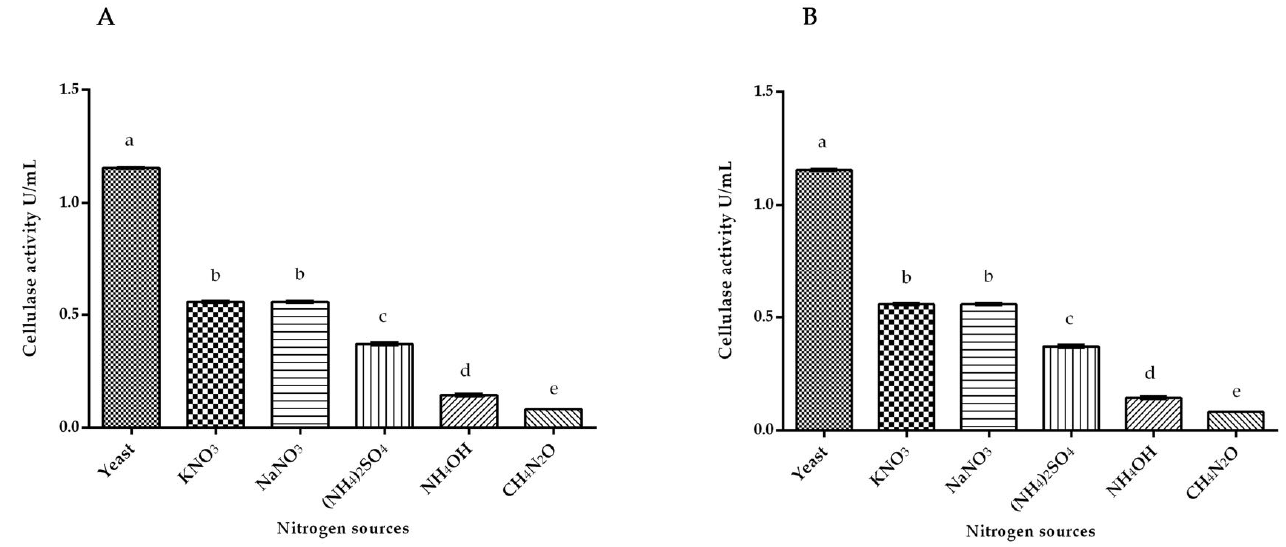
Figure 1. ( A ) Cellulase activity of white rot fungus P . ostreatus under submerged fermentation on different nitrogen inducers. Bars with different letters (a–e) are significantly different at p < 0.05. ( B ) Cellulase activity of white rot fungus P . chrysosporium under submerged fermentation on different nitrogen inducers. Bars with different letters (a–e) are significantly different at p < 0.05.